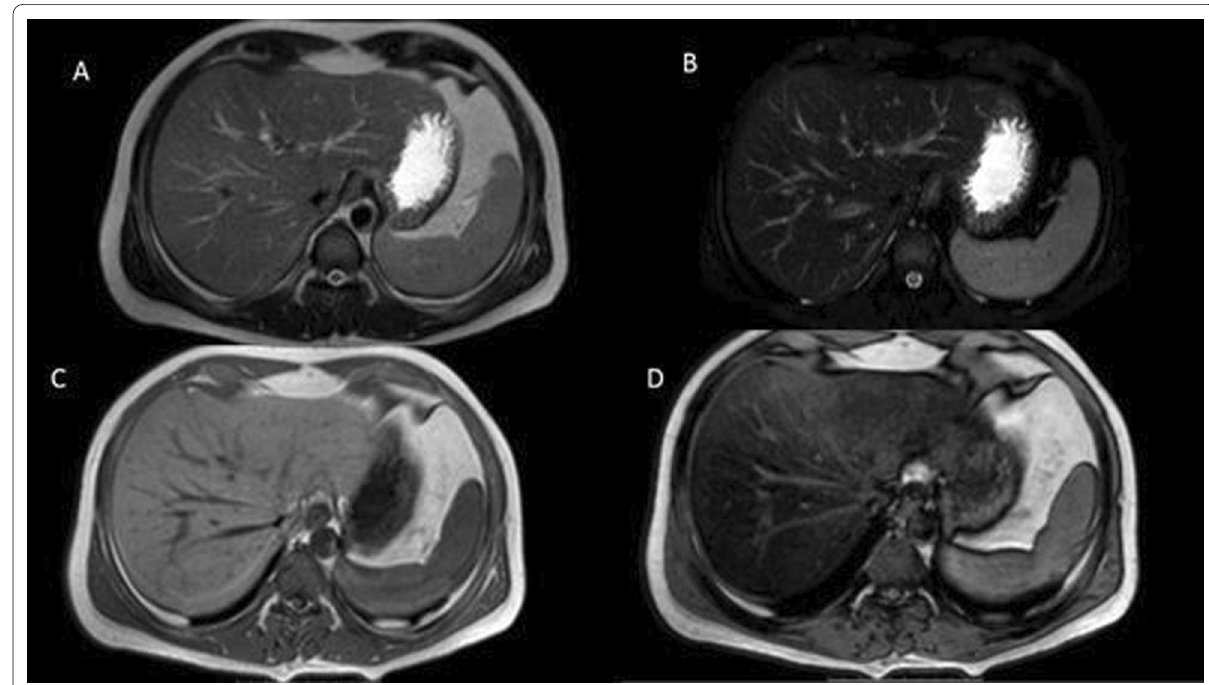
Fig. 5 A 30-year-old male patient with CHC A axial T2WI, B axial SPIR, C axial T1-in-phase, D T1-out-of-phase. A , B Signal intensity of the liver drops compared to spleen because the fat-saturated pulse suppresses the signal from fat within the liver. C , D Marked signal dropout on out-of-phase imaging indicating the presence of diffuse steatosis with calculated fat fraction and fat percentage about 30.40 and 33.44, respectively, indicating severe